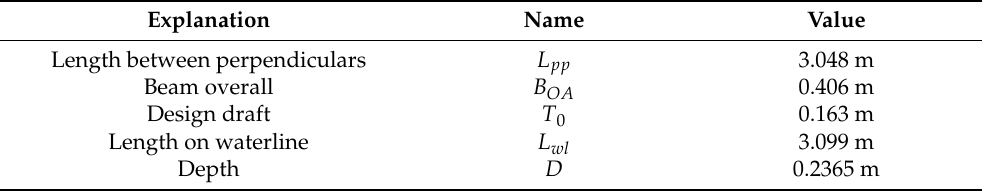
Table 1. Principal dimensions of the standard Series 60